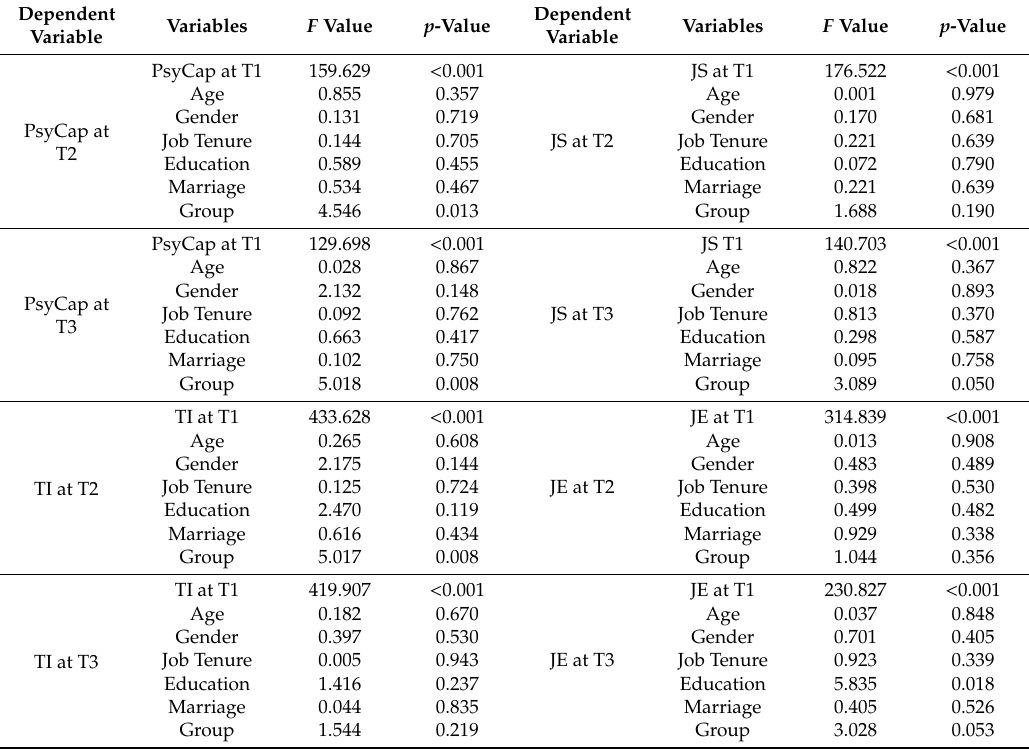
Table 3. Analysis of covariance (ANCOVA) controlling for study variables at T1, demographic, and job